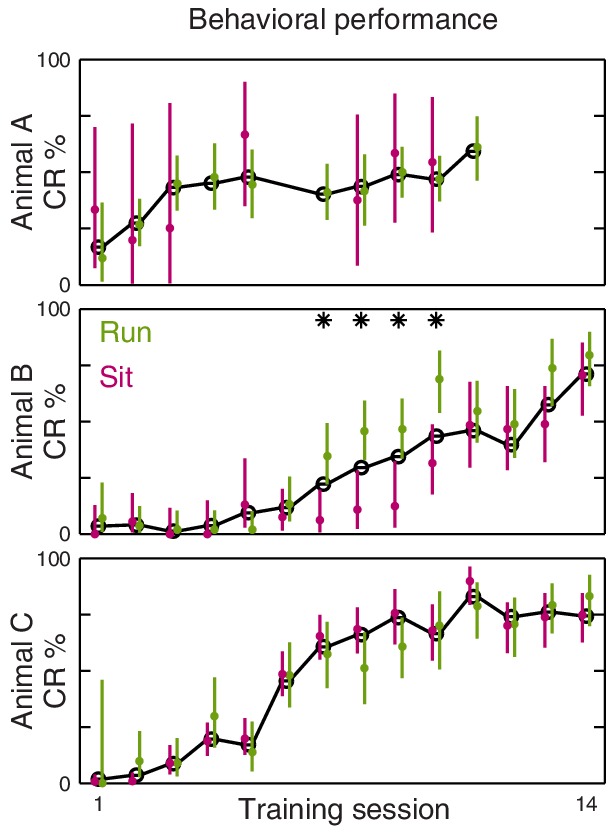
Eyeblink performance is not impaired in running trials.Plots show behavioral performance over the course of training for the three animals. The mean CR rate over all trials is shown in black. Mean with 95% Bernoulli confidence intervals for running/sitting trials are shown in green/magenta, respectively. Asterisks indicate sessions where either confidence interval does not include the overall mean.